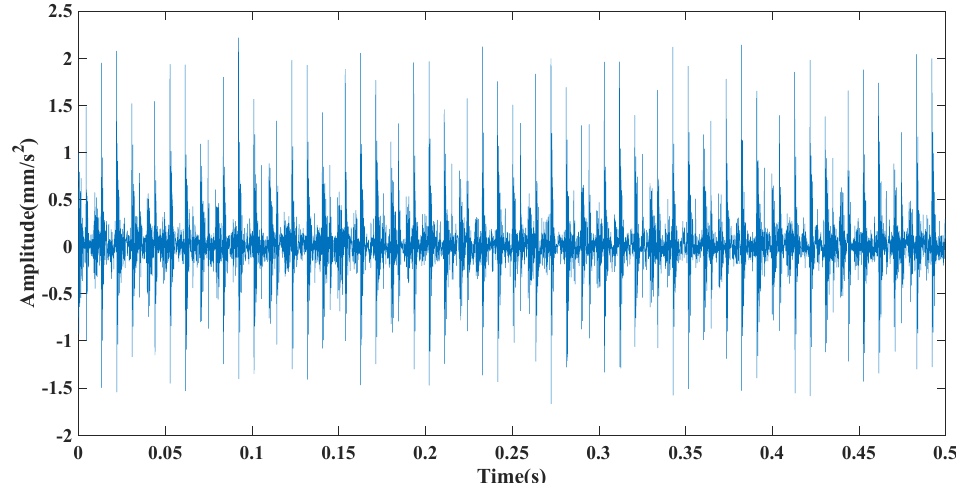
Figure 2. Time domain diagram of the simulation signal.